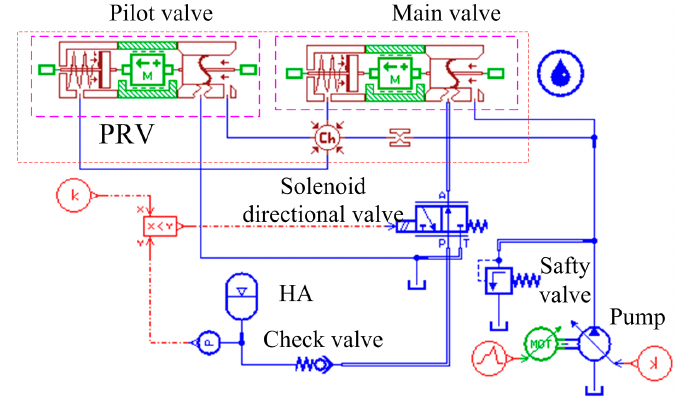
Figure 5. Simulation model in AMESim.